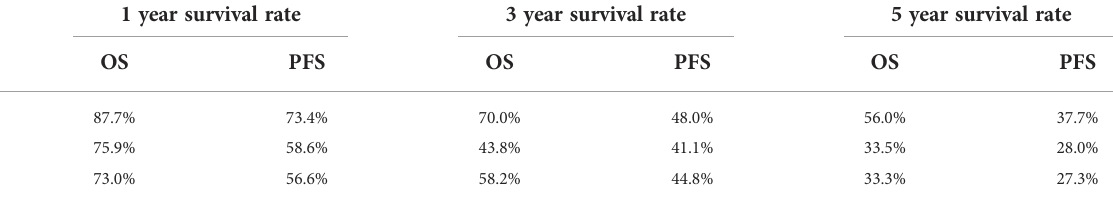
TABLE 3 Survival comparison of the three